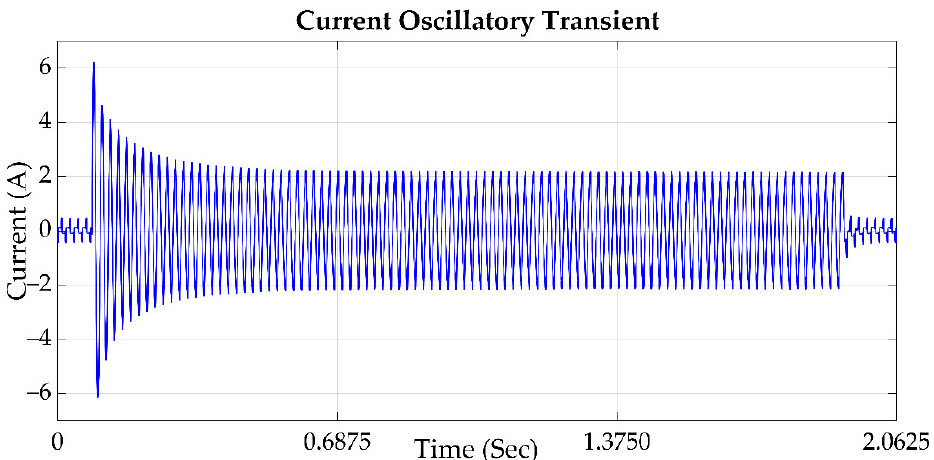
Figure 2. A current signal which contains an oscillatory transient.